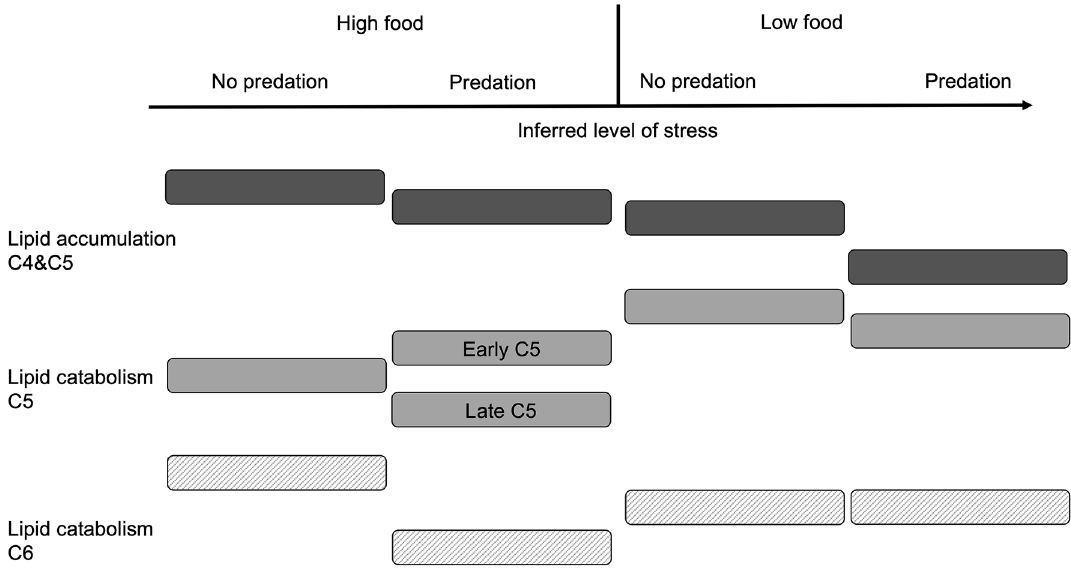
Figure 5. Illustration of overall lipid metabolism patterns (accumulation C4&C5: black, catabolism C5: dark grey, catabolism C6: light grey) in Calanus finmarchicus exposed to presence or absence of a predator cue in combination with high or low food availability while developing from C4 to C5 and further to C6. We assume that the treatment with no predator cue and high food availability represent the lowest level of percieved stress, and that the stress level increases with predator presence and low food availability. The placement of each box relative to the others are derived from the lipid fullness results and/or gene expression results. For example, lipid catabolism in C6s in the treatment with high food and no predation has more upregulated genes than the other treatments, and this box is therefore placed higher than the other